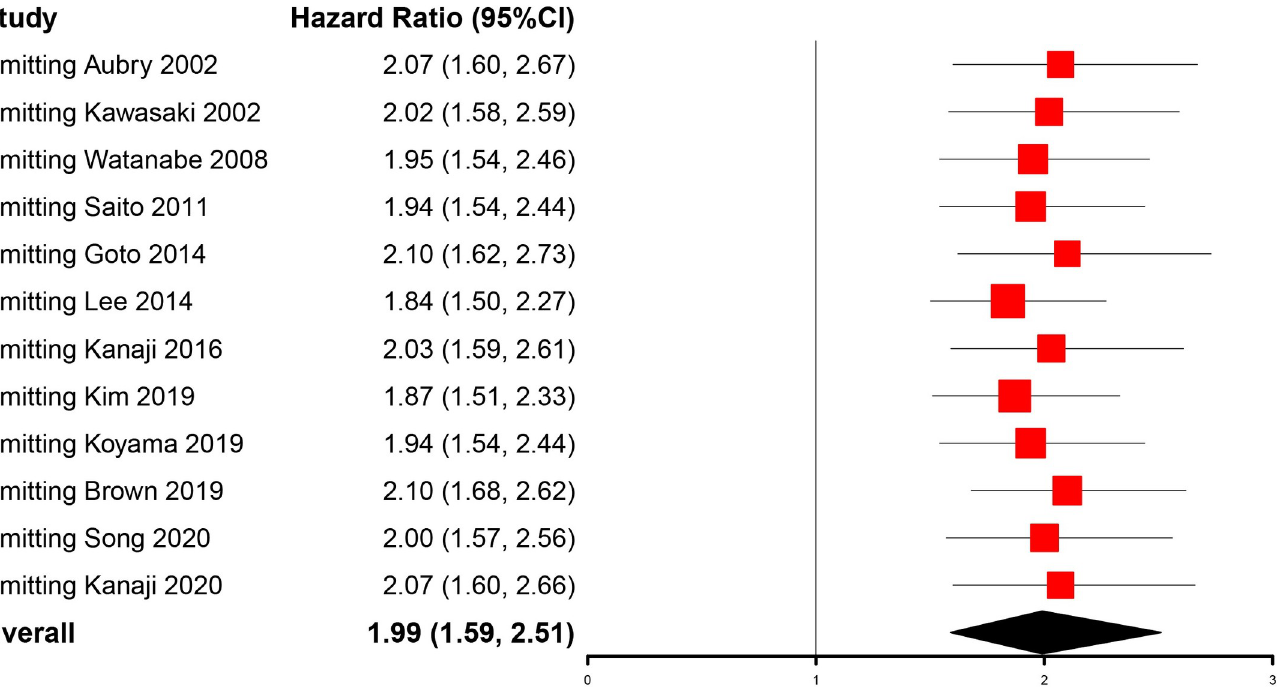
Fig 4. Sensitivity analysis by excluding each study from